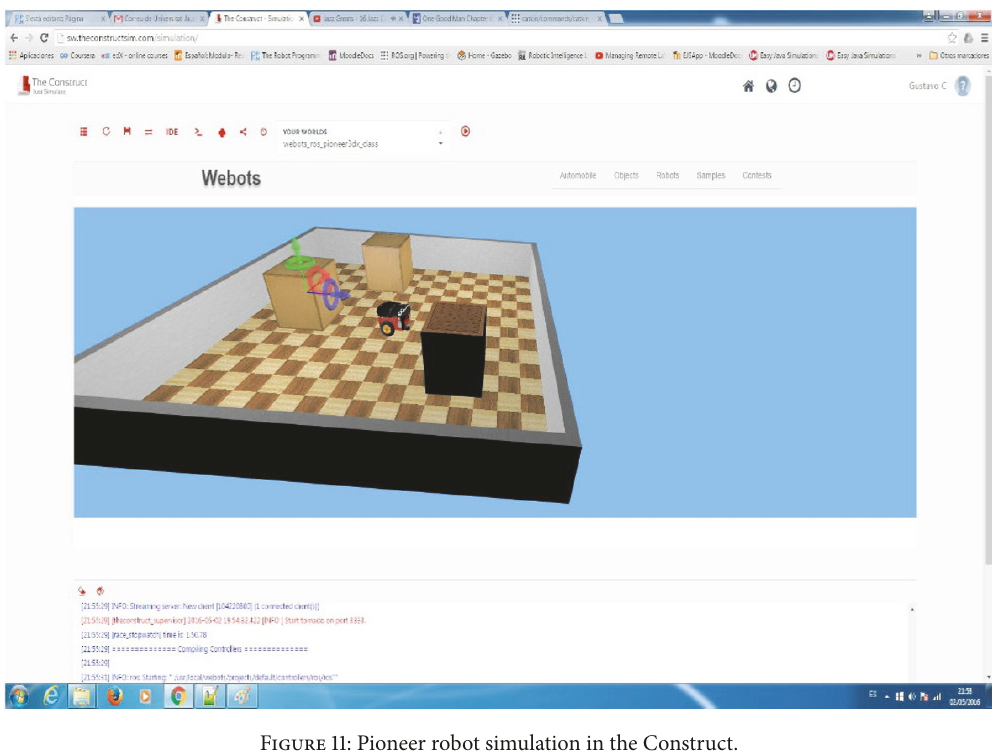
Figure 11: Pioneer robot simulation in the Construct.